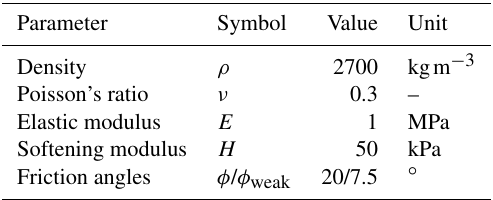
Figure 11. Geometry for the earth slump. The number of elements in the y direction n el ,y and the width of the problem l y are variable. This allows us to increase (or decrease) the number of both elements and material points without decreasing the mesh resolution. The pa- rameter n controls the dimension of the domain and the number of elements in the y direction. The wall-clock time depends only on the total number of elements, nodes and material points and is not influenced by the mesh resolution.